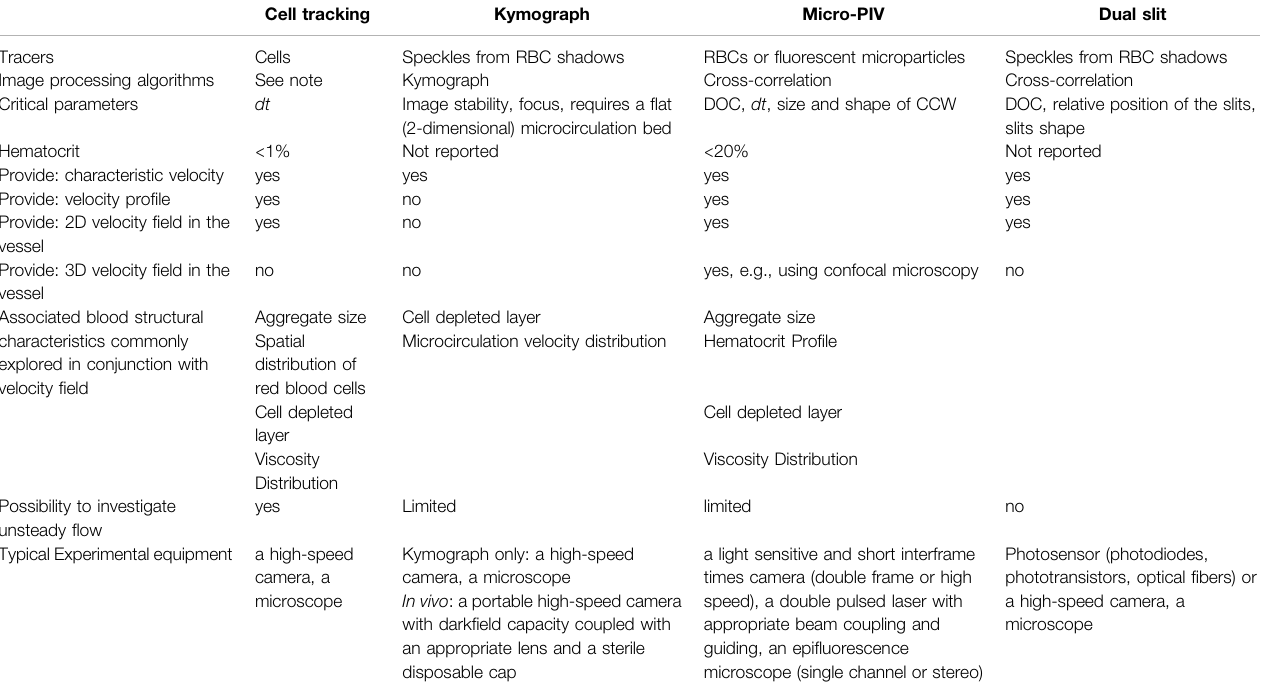
TABLE 1 | Comparison of image-based experimental measurement techniques to characterize velocity fi elds in blood micro fl